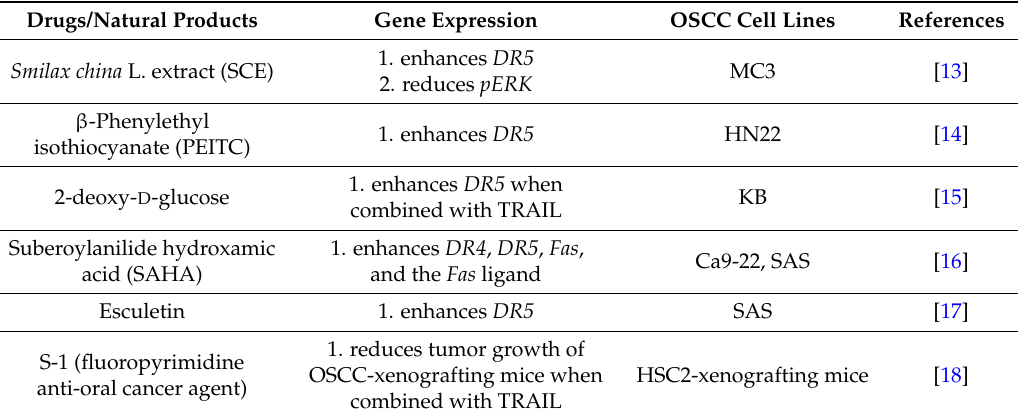
Table 1. Drugs and natural products that regulate the tumor necrosis factor-related apoptosis-inducing ligand (TRAIL) signaling